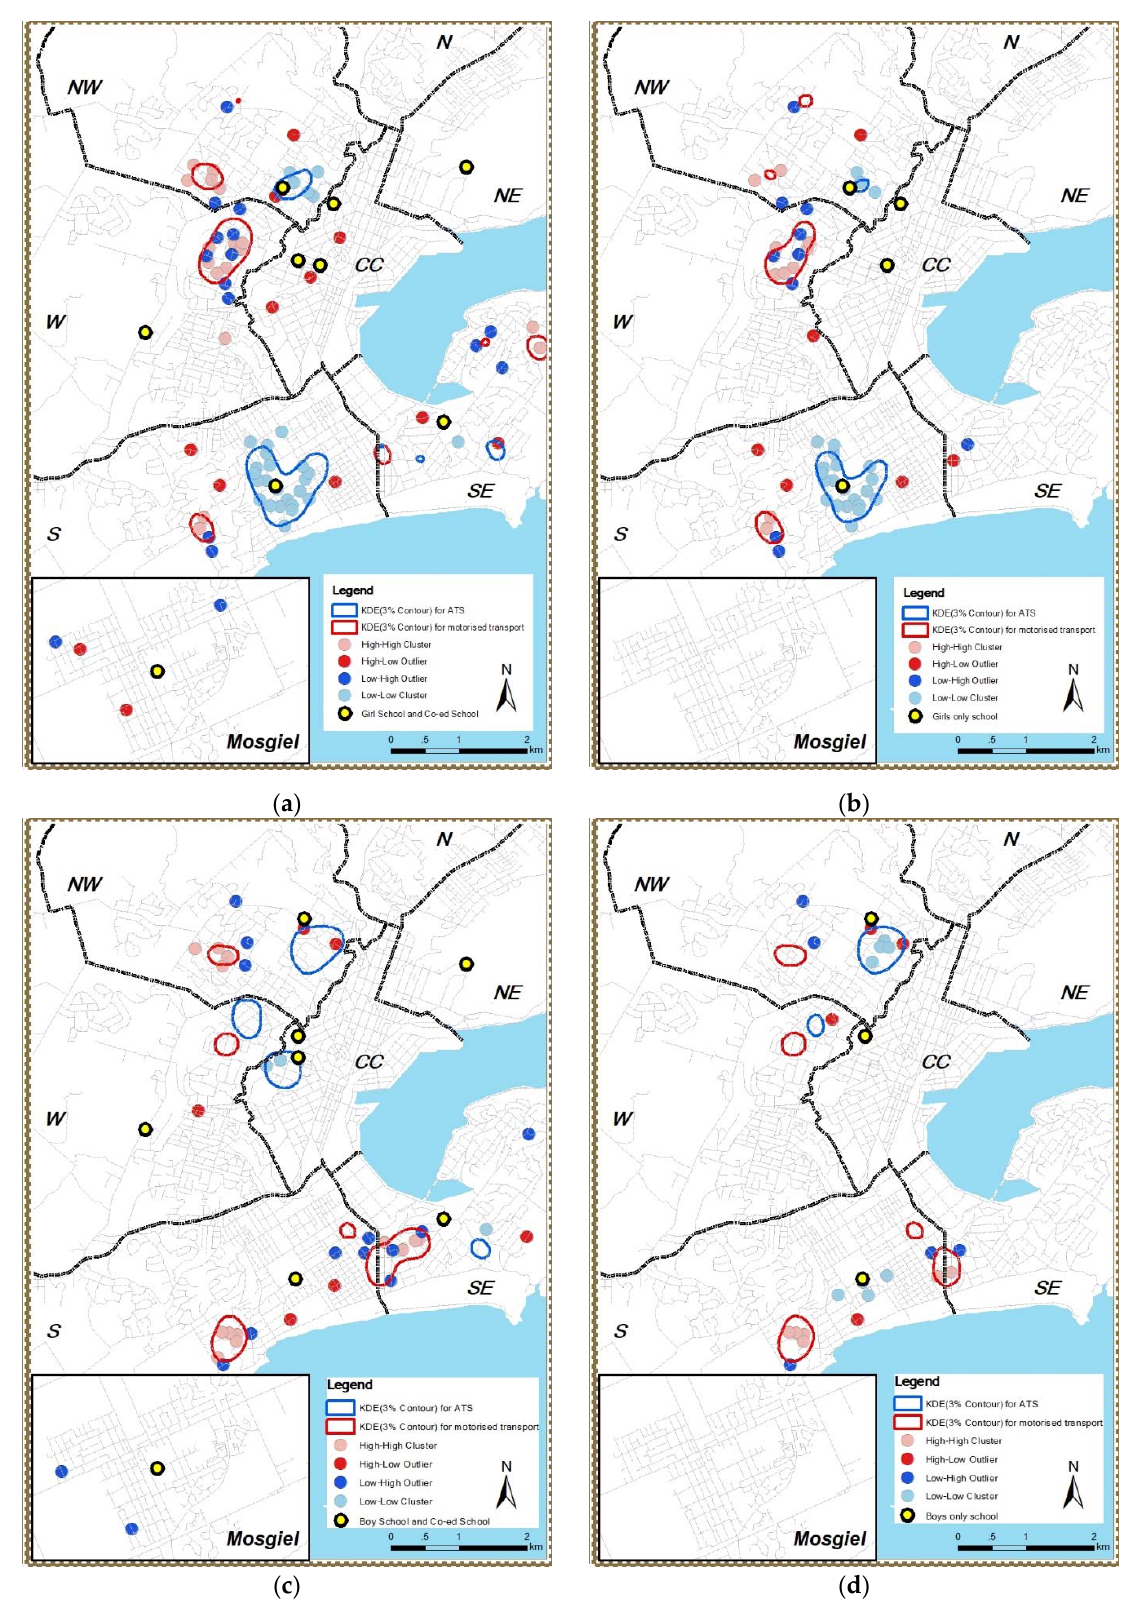
Figure 2. KDE and LISA transport modes distribution on gender and co-educational school attending status: ( a ) female; ( b ) girls-only school attenders; ( c ) male; ( d ) boys-only school attenders.